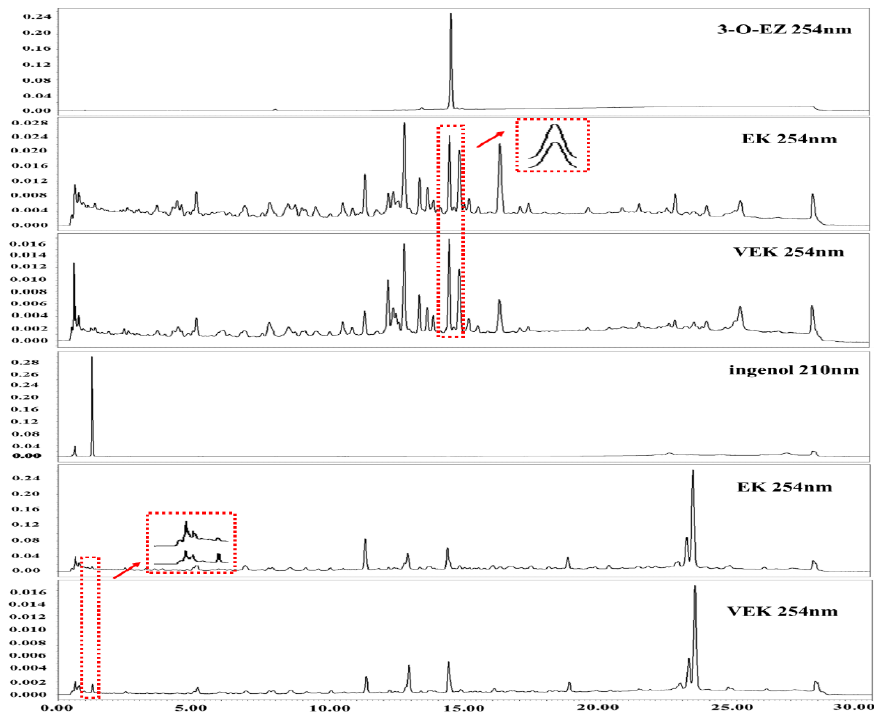
Figure 2. UPLC of the 3-O-EZ and ingenol in Euphorbia kansui (EK) and EK stir-fried with vinegar